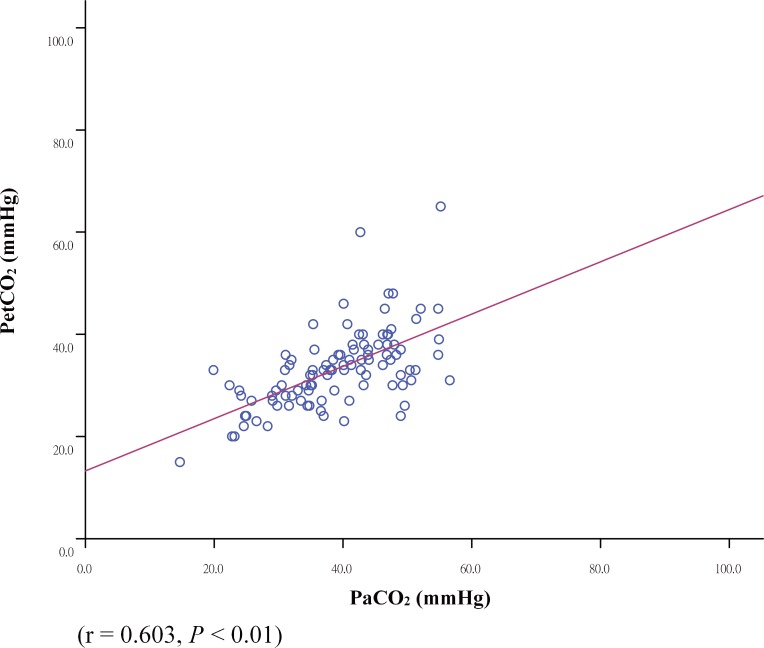
Scattergram plot of the relationship between PaCO2-PetCO2.